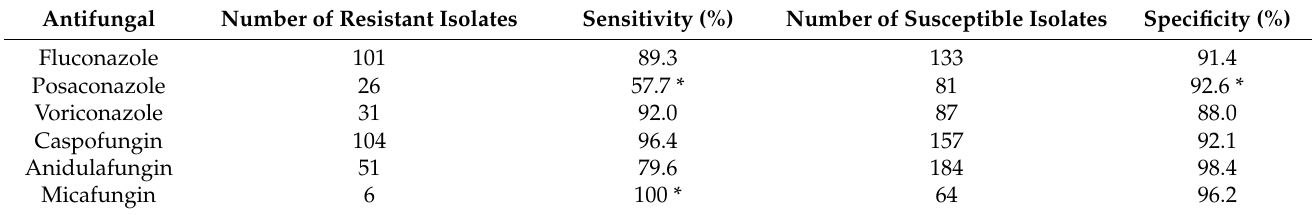
Table 2. Sensitivity and specificity by antifungal agent.